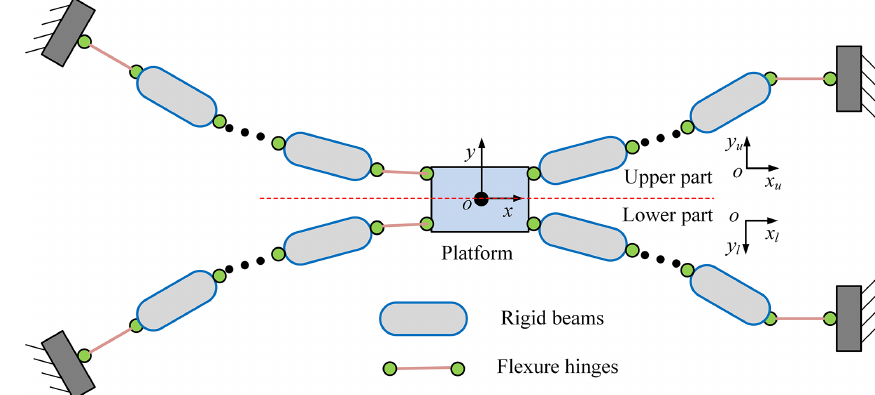
Figure 3. Mechanism with symmetric configuration about the x axis.